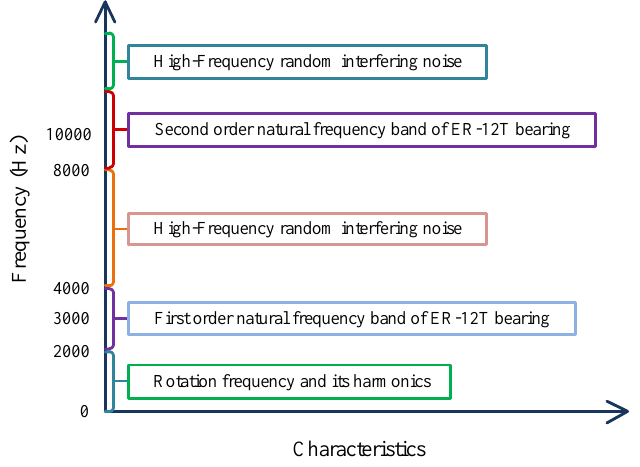
Figure 14. Frequency distribution of rolling bearing ER-12T.